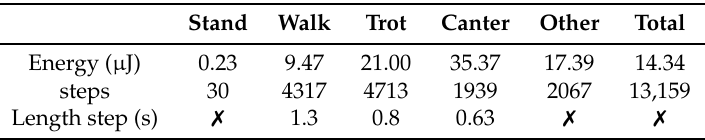
Table 4. Number of total recorded steps and their average energy in the gaits. Stand